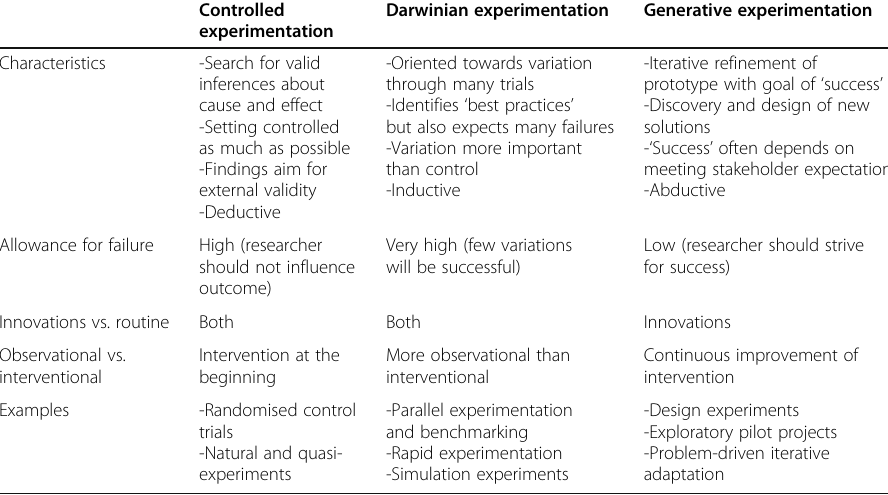
Table 1 Comparison of three logics of experimentation Characteristics -Search for valid